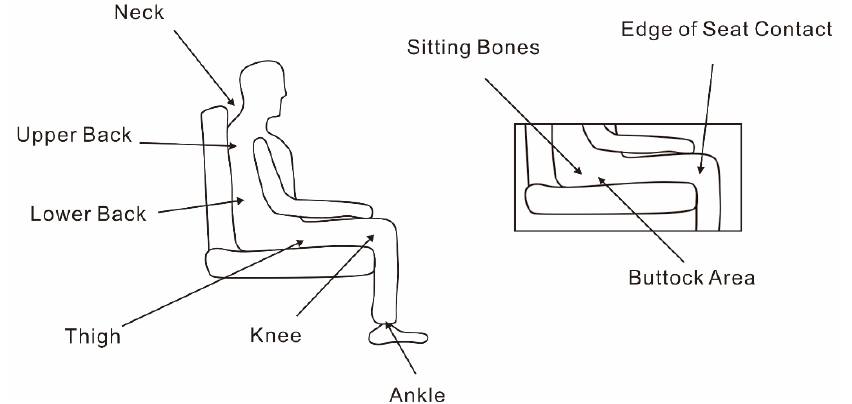
Figure 2. The body map for the local discomfort, adapted from the body map proposed by ISO 2631-1:1997.